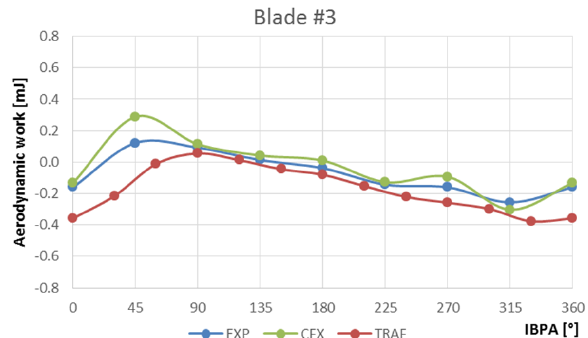
Figure 21. Aerodynamic work of blade torsion mo- tion - blade #5: experimental (EXP), CFX and TRAF